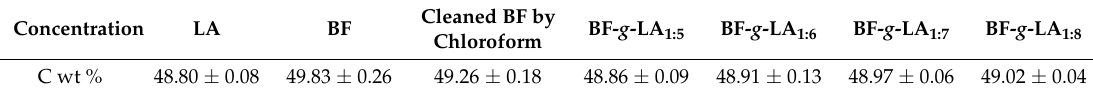
Table 4. Carbon content of LA, BF, and BF- g -LA determined by elemental analysis.